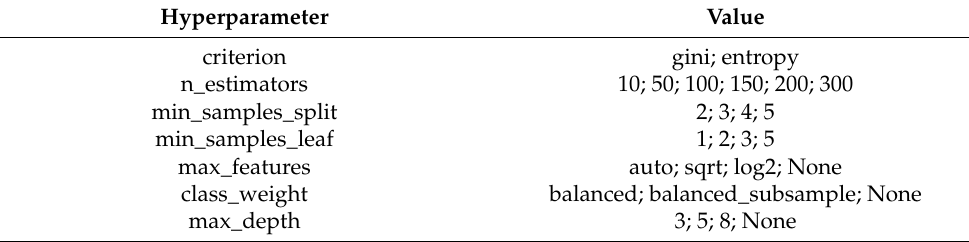
Table 4. Tested hyperparameters of the ExtraTreesClassifier